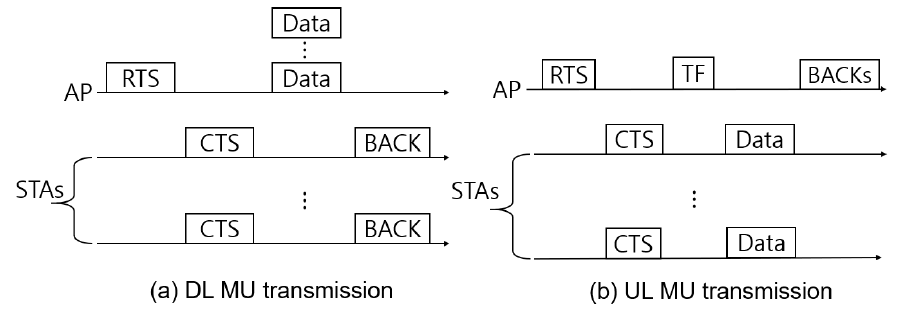
Figure 4. Simplified DL and UL transmissions of IEEE